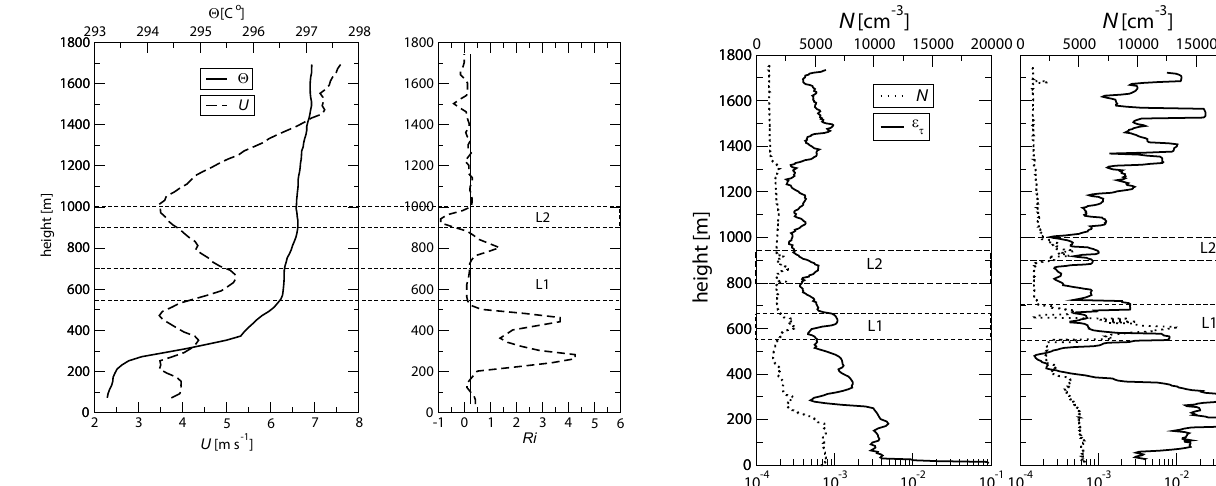
Fig. 7. Vertical profiles of smoothed 2 and U (left panel) from which vertical gradients are estimated. The right panel shows the gradient Richardson number. The vertical line at Ri=0.25 indicates the critical value, for Ri < 0.25 turbulence can develop whereas for Ri > 0.25 the damping effect of the temperature inversion becomes dominant.